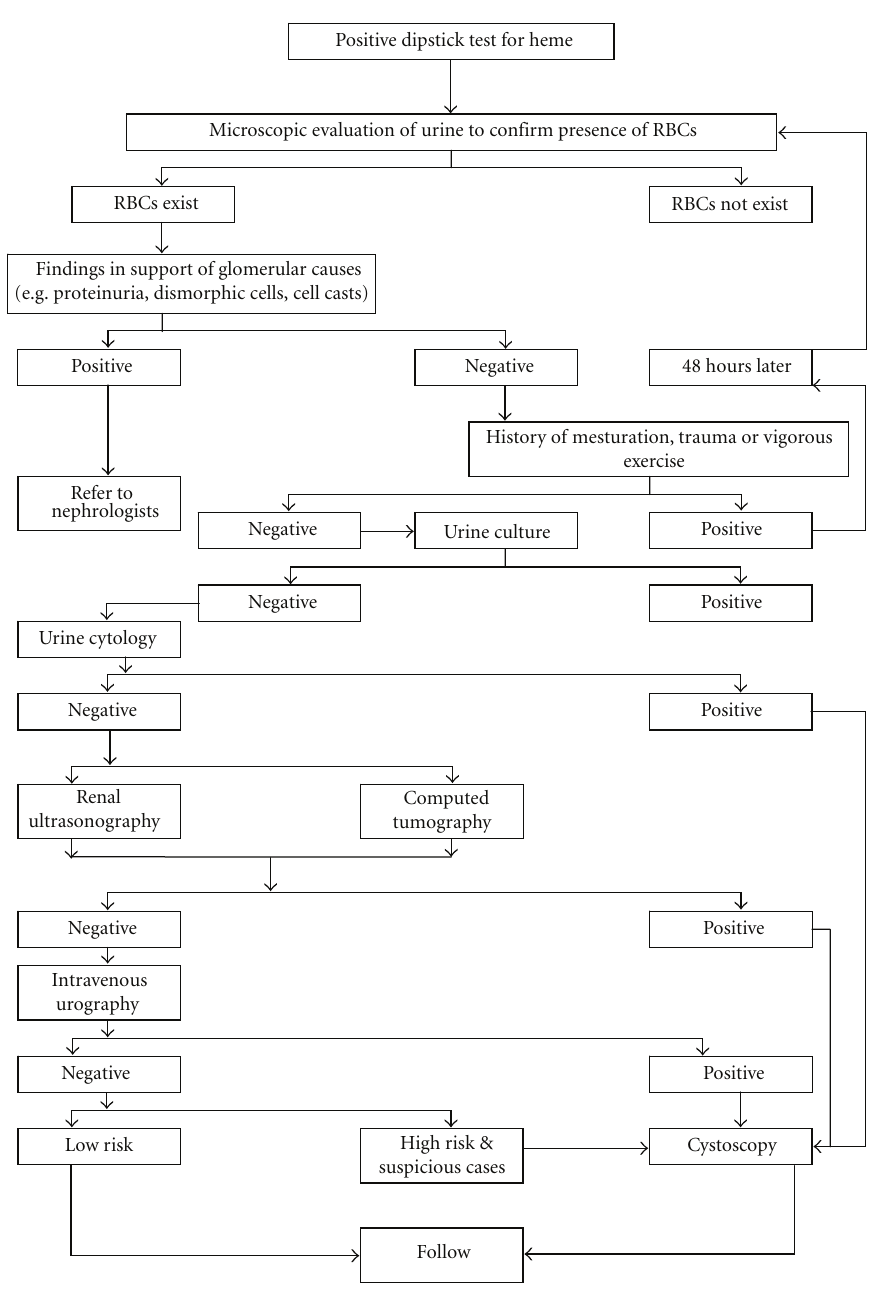
Figure 1: Algorithmic approach to microscopic hematuria in